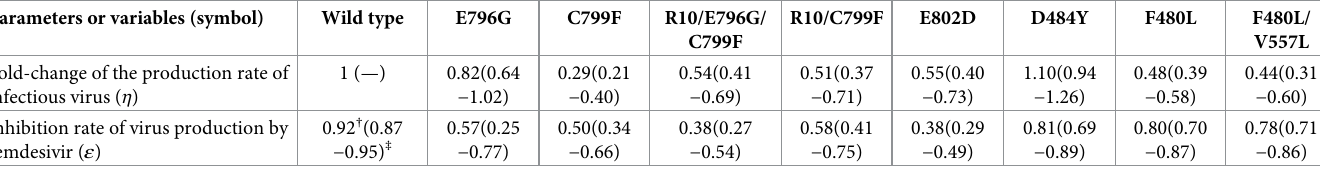
Inhibition rate of virus production by remdesivir ( ε